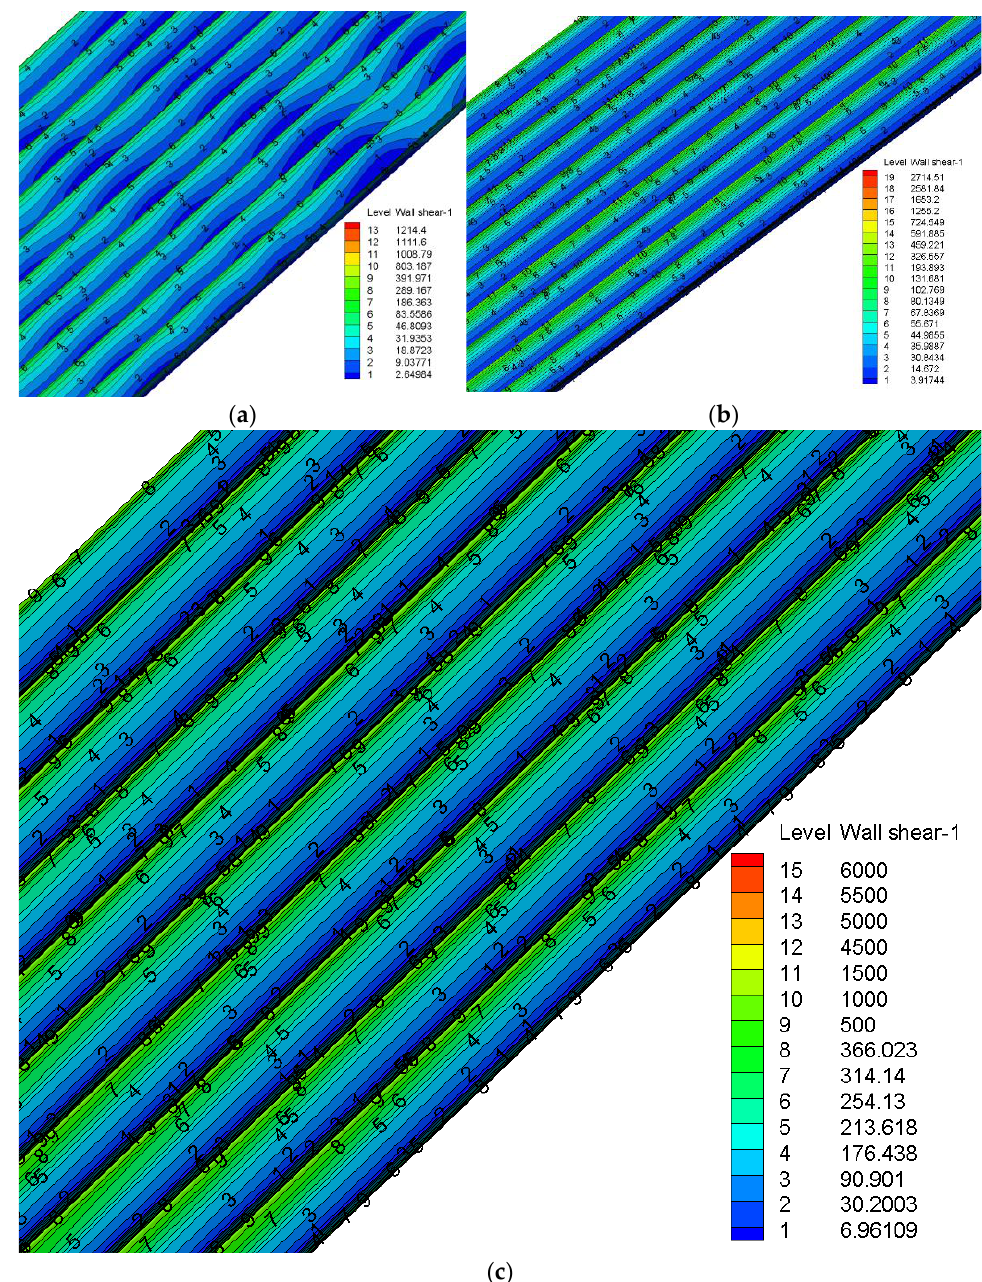
Figure 18. Wall shear stress distribution of triangular groove plate under different Mach numbers; ( a ) 0.3 Ma; ( b ) 0.5 Ma; and ( c ) 0.8 Ma. To further analyze the wall shear stress, the straight lines along the flow direction were taken at the top, middle and bottom of the wall of the triangular groove, respectively. The specific position was at the flow direction x = 0.00375 m, and the span z = 0.00050625 m, z = 0.000525 m, and z = 0.00054375 m, respectively, and the data on the straight lines were extracted. The shear stress coefficient distribution curve is shown in Figure 19.